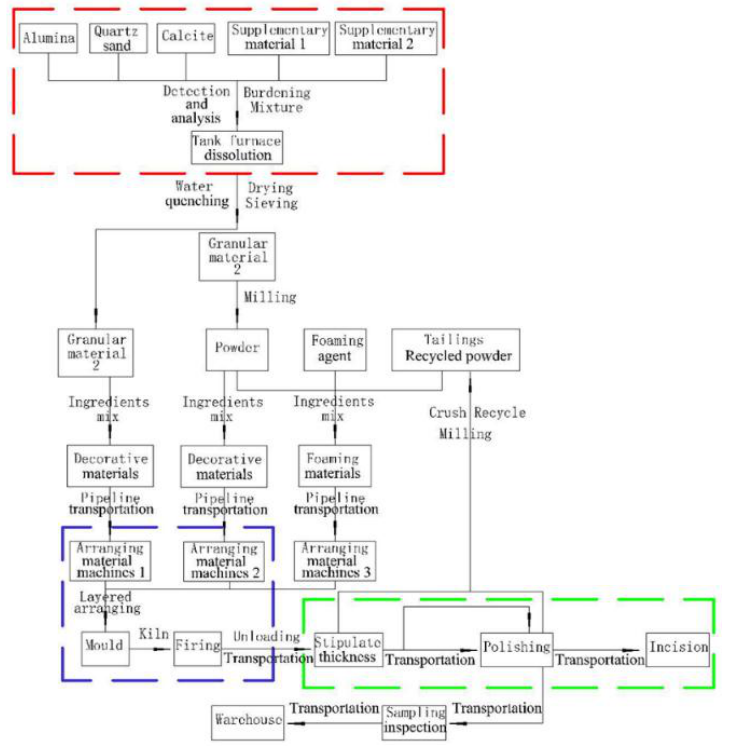
Figure 2. Production process of